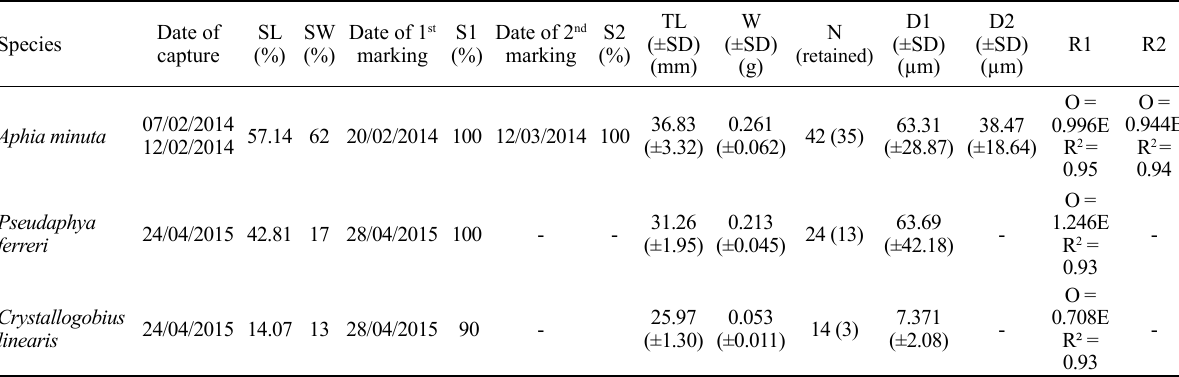
Table 1. – Experimental procedures, survival after capture and marking, mean length and weight of the fishes and otolith growth relationships. Only data of surviving fishes and repeated readings with a coefficient of variation of less than 10% were considered. SD, standard deviation. SL, survival at landing; SW, survival at 1st week; S1, survival to 1st marking; S2, survival to 2nd marking; TL, fish mean total length; W, fish mean weight; N, number of otoliths examined; D1, mean distance from the 1st mark to the otolith edge; D2, mean distance from the 2nd mark to the otolith edge; R1, relationship between observed (O) and expected (E) number of daily growth increments (in days) for the 1st mark; R2, relationship between observed (O) and expected (E) number of daily growth increments (in days) for the 2nd mark. Date of Species